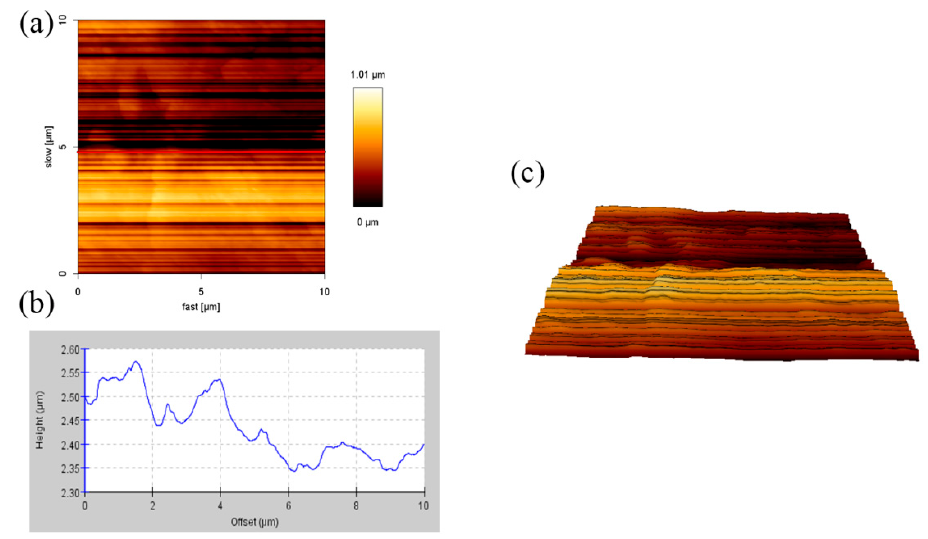
Figure 2. AFM images (10 × 10 µm) the side of anti-fogging agent of 1% SiO 2 double layer films: ( a ) A height image; ( b ) cross-section height profiles along the line in ( a ), and ( c ) a 3D reconstruction image.